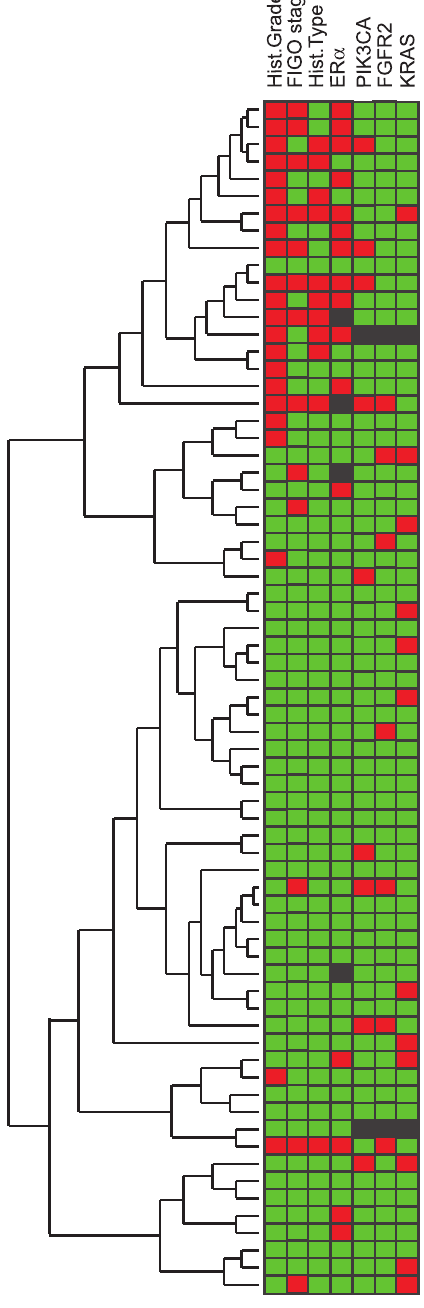
Figure 1. Mutational status is not reflected in distinct patient clusters related to phenotype. A hierarchical clustering of 306 significantly differentially expressed genes between grade I–II and grade III was mapped with clinico-pathological data and mutational status to visualize the distribution of mutation across the patient population. Green square color indicate good prognosis groups (Grade I–II, FIGO I–II, endometrioid type, ER a positivity) and no detected mutation in indicated gene, Red square color indicate poor prognosis groups (Grade III, FIGO III–IV, non-endometrioid types, ER a negativity) and detected mutation in indicated gene. Black square: data missing.